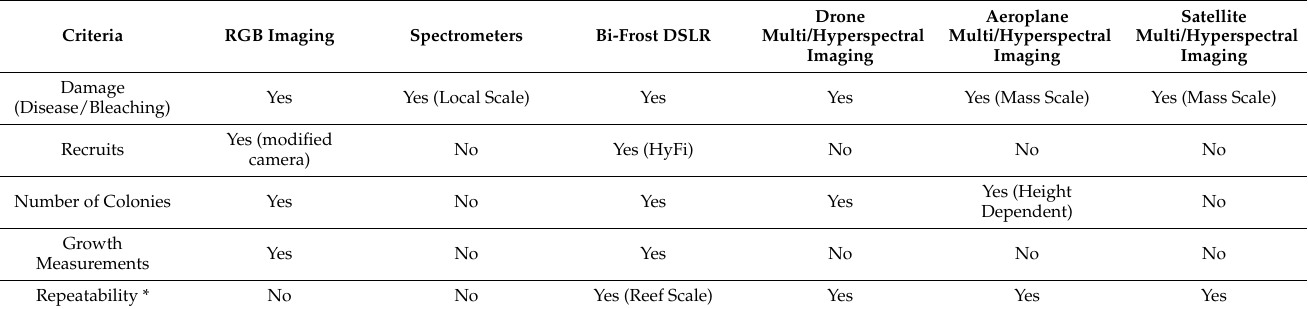
Table 4. An outline of the ability of the different optical techniques to assess important criteria used in coral surveyance as outlined by Leujak and Ormond, 2007